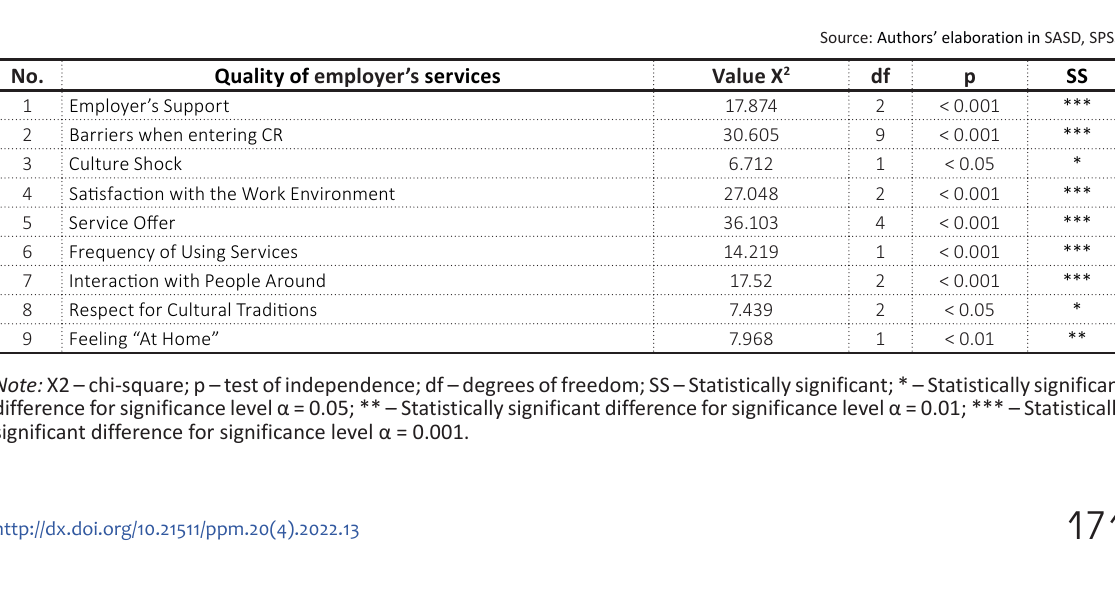
Table 1. Quality of employer’s